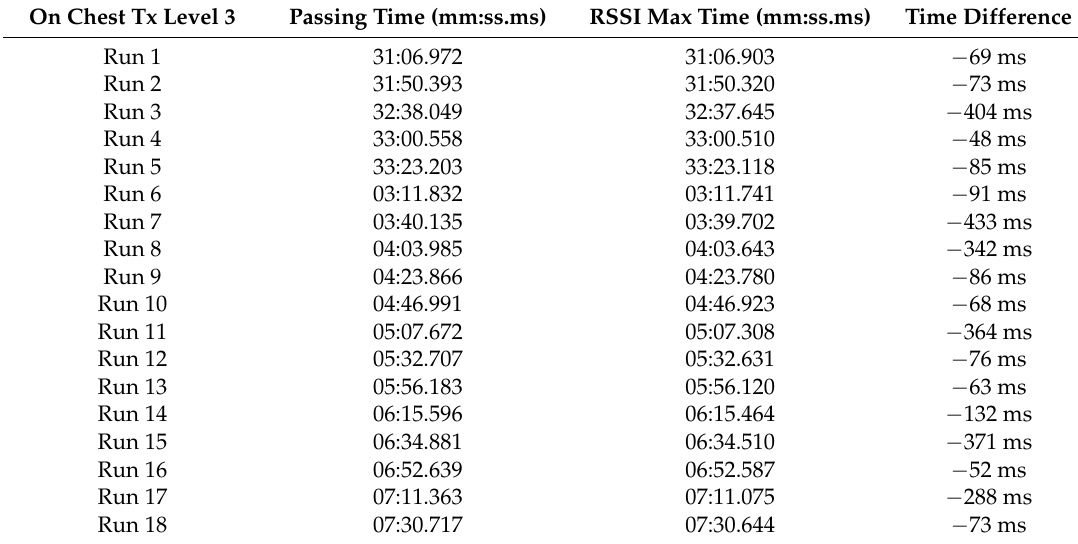
Table 3. The dynamic experiment when the Tx power of the BLE Tag on the chest is set at Level 4. On Chest Tx Level